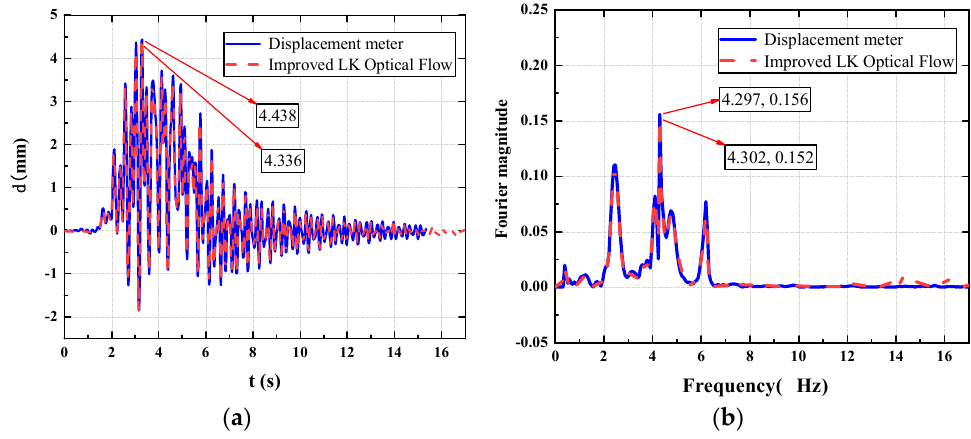
Figure 6. Displacement comparison chart. ( a ) Displacement time-history comparison chart; ( b ) displacement frequency-domain comparison chart.